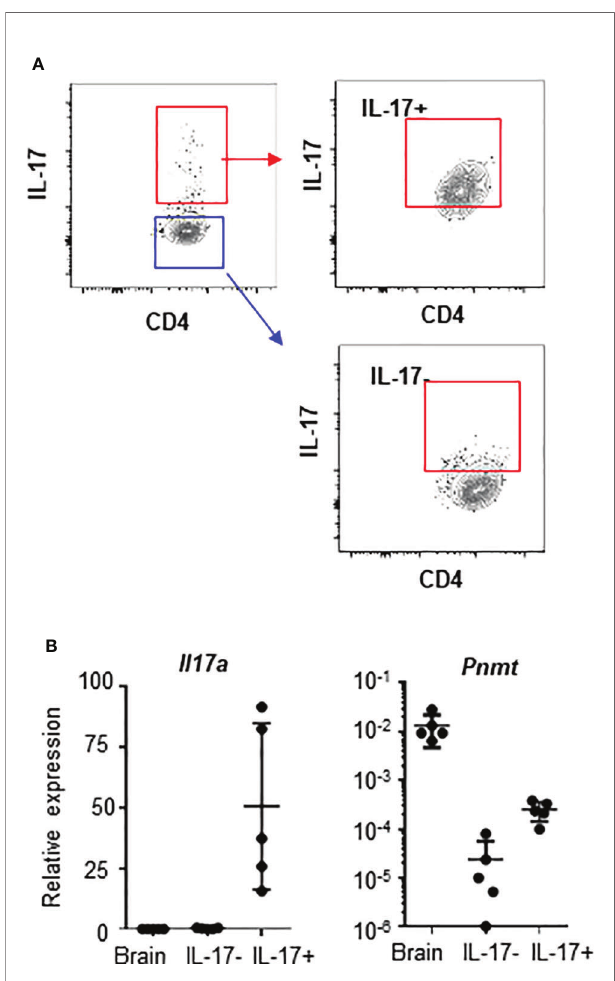
FIGURE 2 | Pnmt expression in T H 17 cells in dLNs. CD4+ T cells were isolated from LNs from 6-8 weeks old C57BL/6 mice. (A) IL-17+ T H 17 cells and IL-17- non-T H 17 cells were enriched and isolated by cell sorter. Purity of IL-17+ and IL-17- cells after sorting was con fi rmed and ~75% of cells are enriched in the positive fraction and less than 5% of cells are contaminated in the negative fraction. (B) Total RNA was prepared from the sorted cells and the levels of Il17A and Pnmt mRNA was measured by qPCR. RNA from whole brain tissue was used as a positive control. Relative expression was calculated based on the level of Polr2a . Each dot represents an individual mouse and the bar represents mean ± SEM (n =